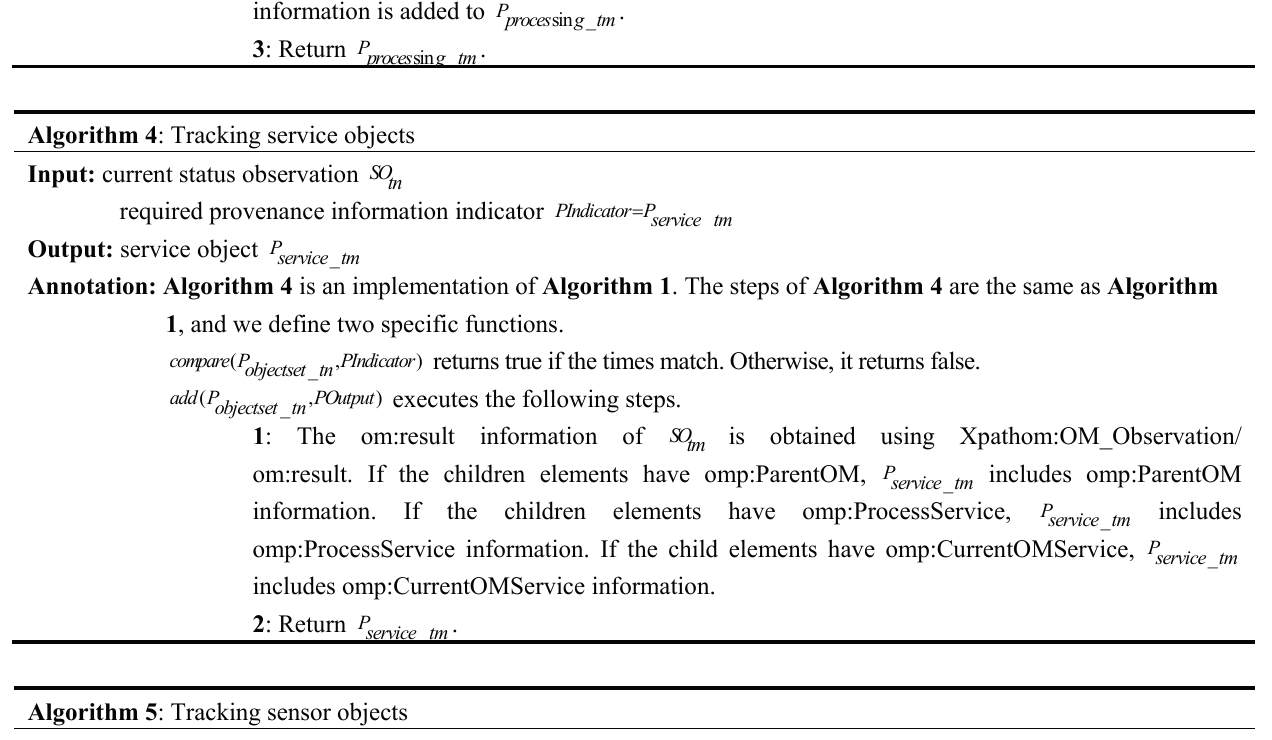
Algorithm 5 : Tracking sensor objects required provenance information